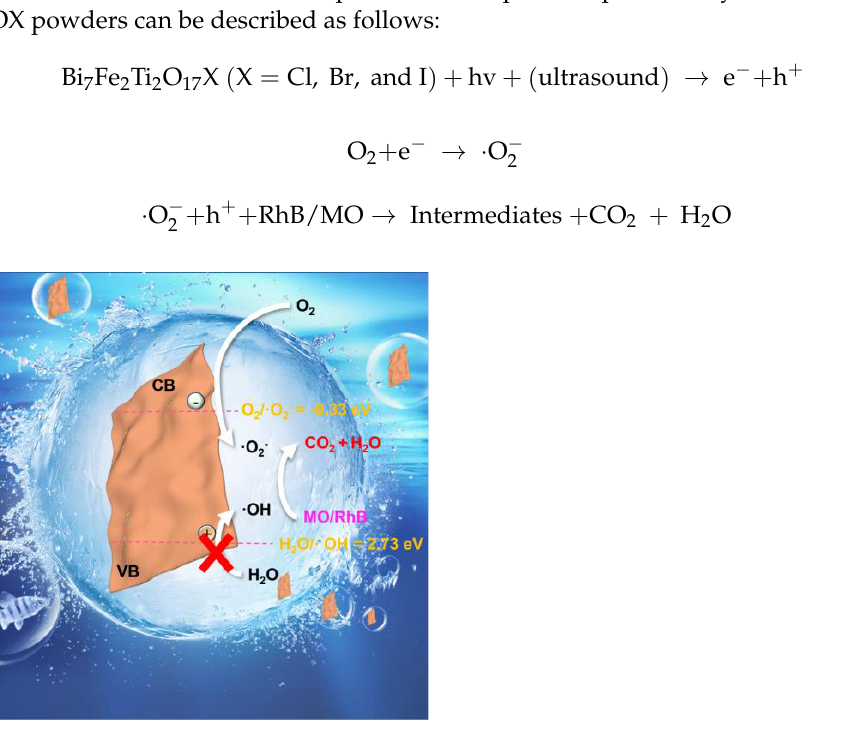
accumulated e - on the CBM of BFTOX readily can reduce oxygen to ·O 2 - , which has more negative potentials (−0.38 eV, −0.56 eV, and −0.72 eV vs. NHE) than the O 2 /O 2- redox po- tential (−0.33 eV vs. NHE). The reason why ·OH ions do not contribute to the photocata- lytic degradation process of organic pollutants is that in the acidic reaction solution, the E VB s of BFTOX (BFTOC 2.28 eV; BFTOB 2.12 eV; BFTOI 2.01 eV) are more negative than